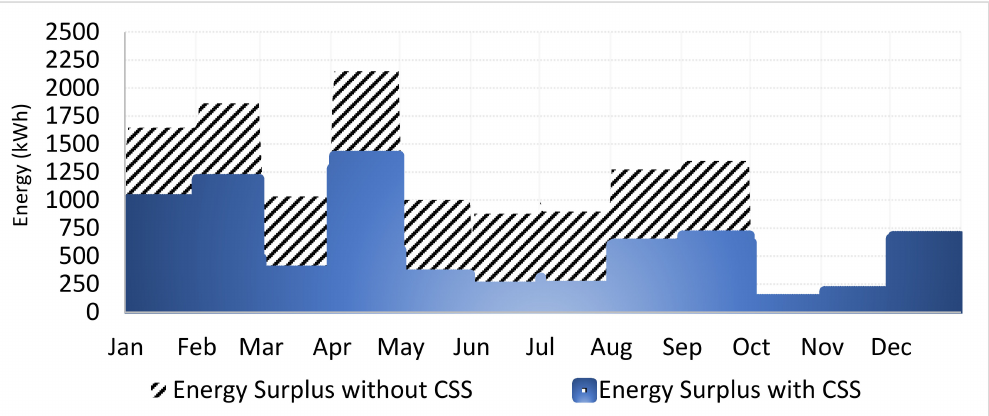
Figure 18. Monthly surplus energy from RES with BSS and